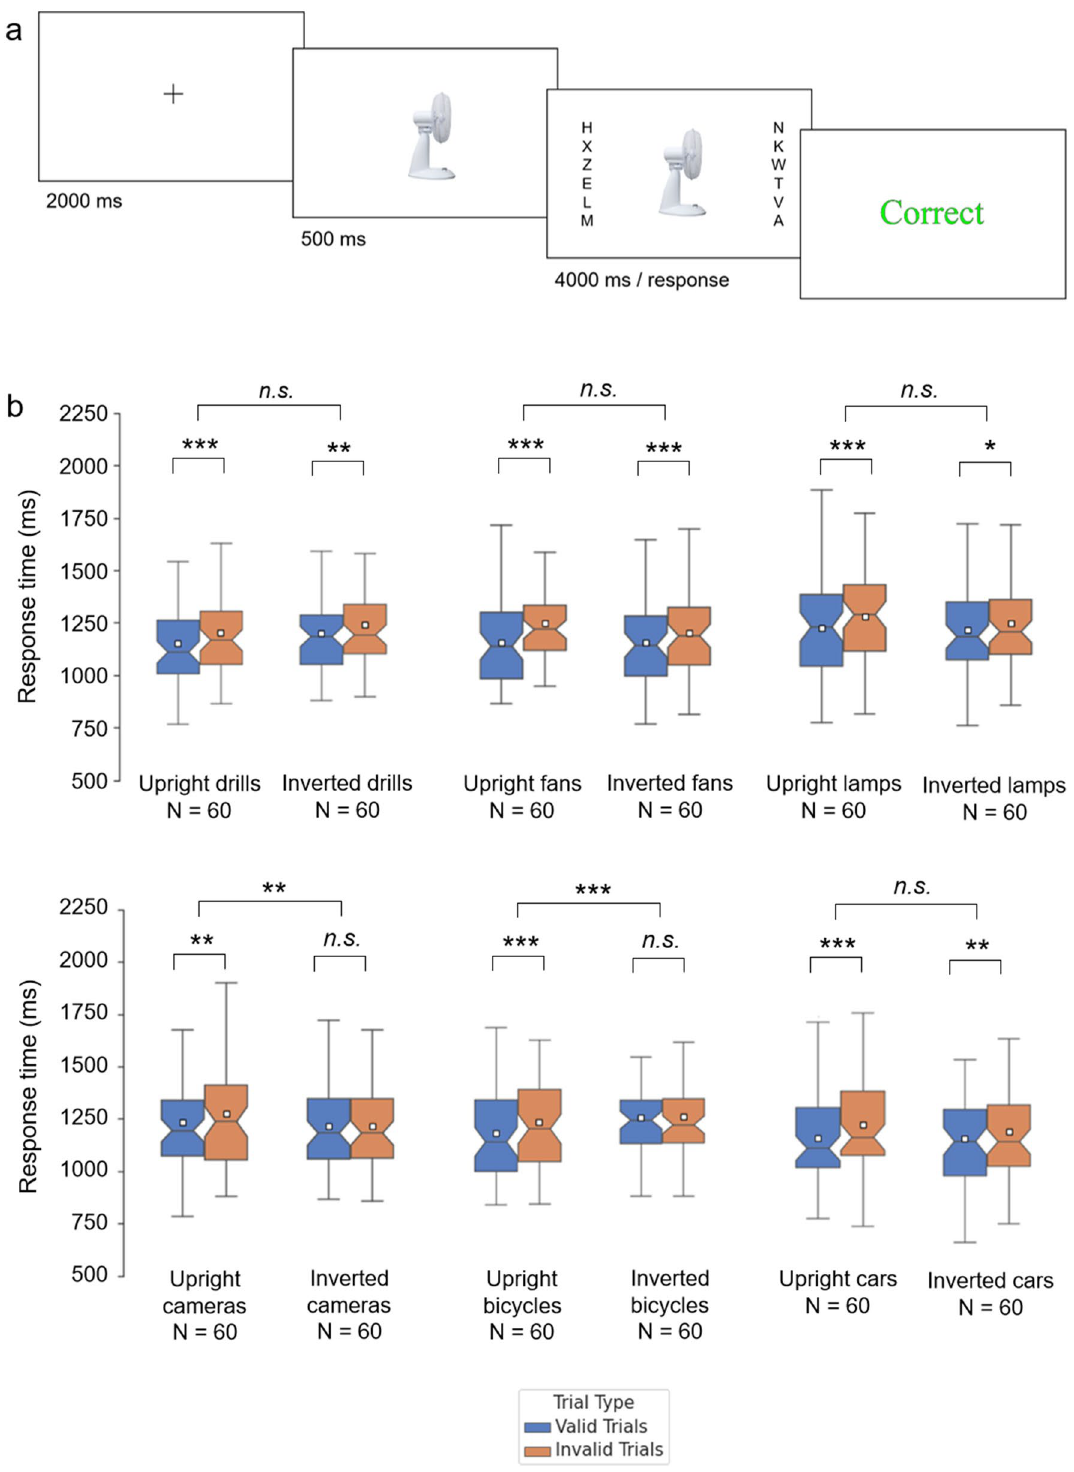
Figure 2. ( a ) Structure of a trial from the desk fans experiment. The fan image included in this schematic was not used as a stimulus image but is representative of the stimuli employed. This image was created by the authors for illustrative purposes. ( b ) Results from the cueing experiments conducted with common objects. Boxes indicate inter-quartile range. Notches indicate confidence interval of the median. Whiskers indicate 1.5 * interquartile range. White squares denote the mean. *** denotes significance at p < .001. ** denotes significance at p < .025. * denotes significance at p <